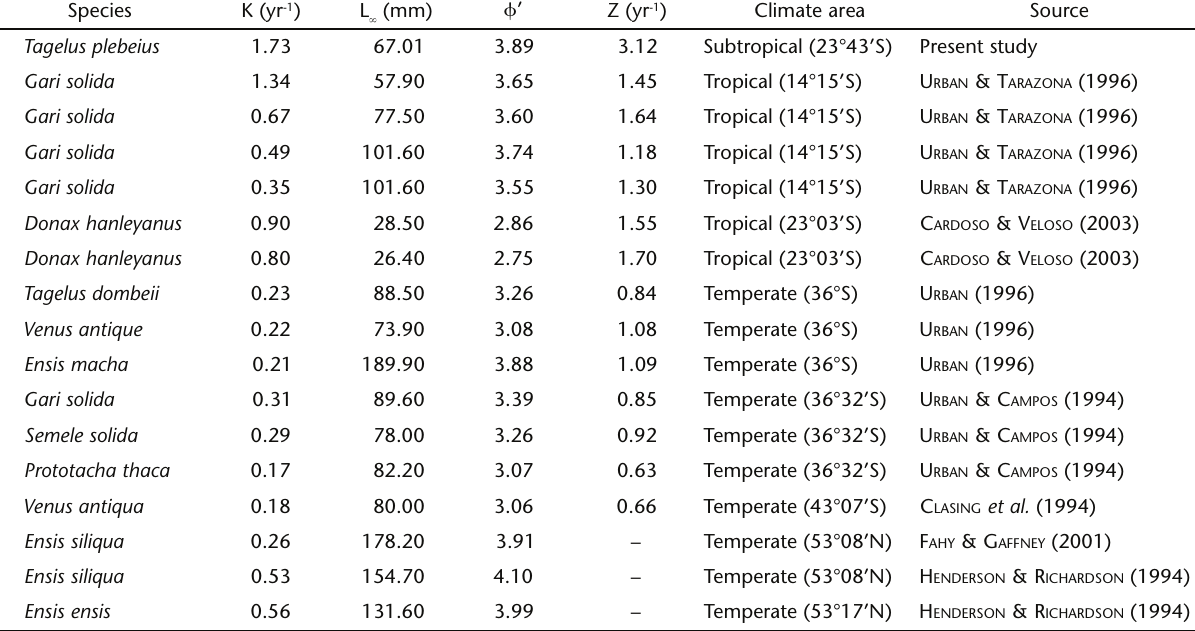
Table III. Latitudinal variation in growth performance and mortality of different bivalves species. (K) Curvature parameter, (L (cid:2) ) asymptotic length, ( (cid:3) ’) standard growth index, (Z) mortality rate. (mm) (cid:3) ’ Z (yr -1 ) Species K (yr -1 ) L (cid:2) Tagelus